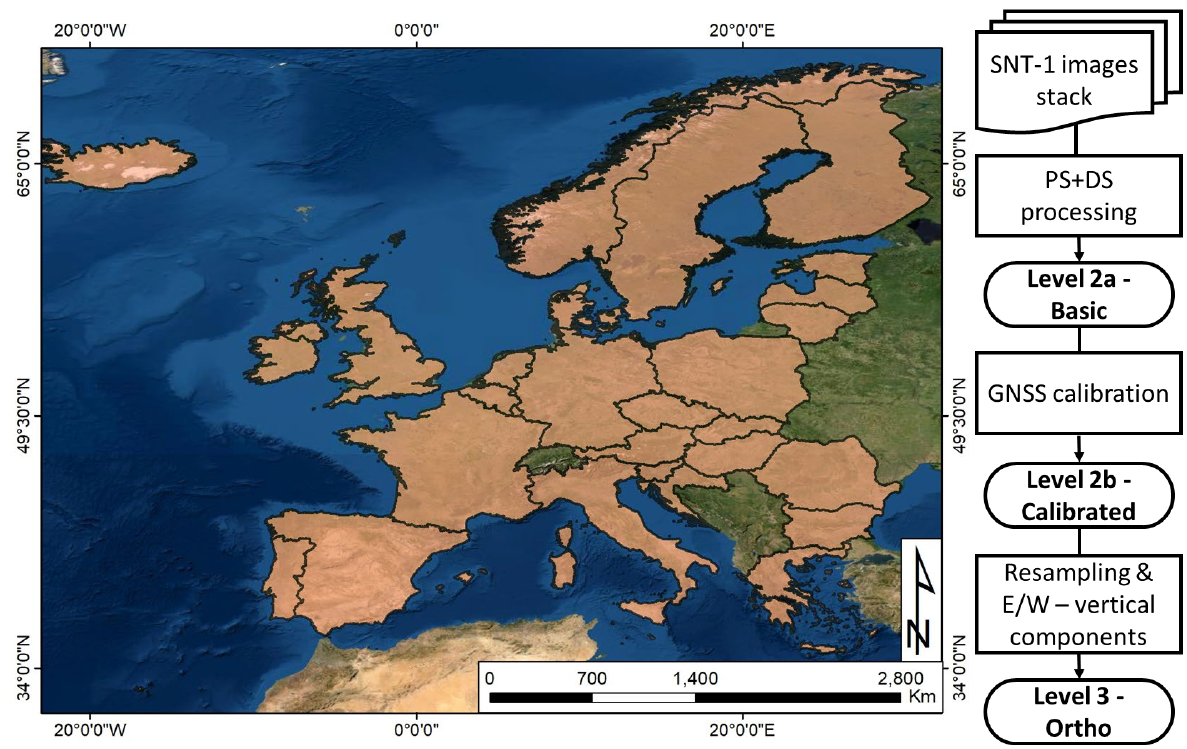
Figure 3: Left – EGMS coverage; the Azores and Madeira archipelagos, the Canary and Baleares islands, the French Overseas Departments and Regions are included. Right – Simplified flowchart of the EGMS